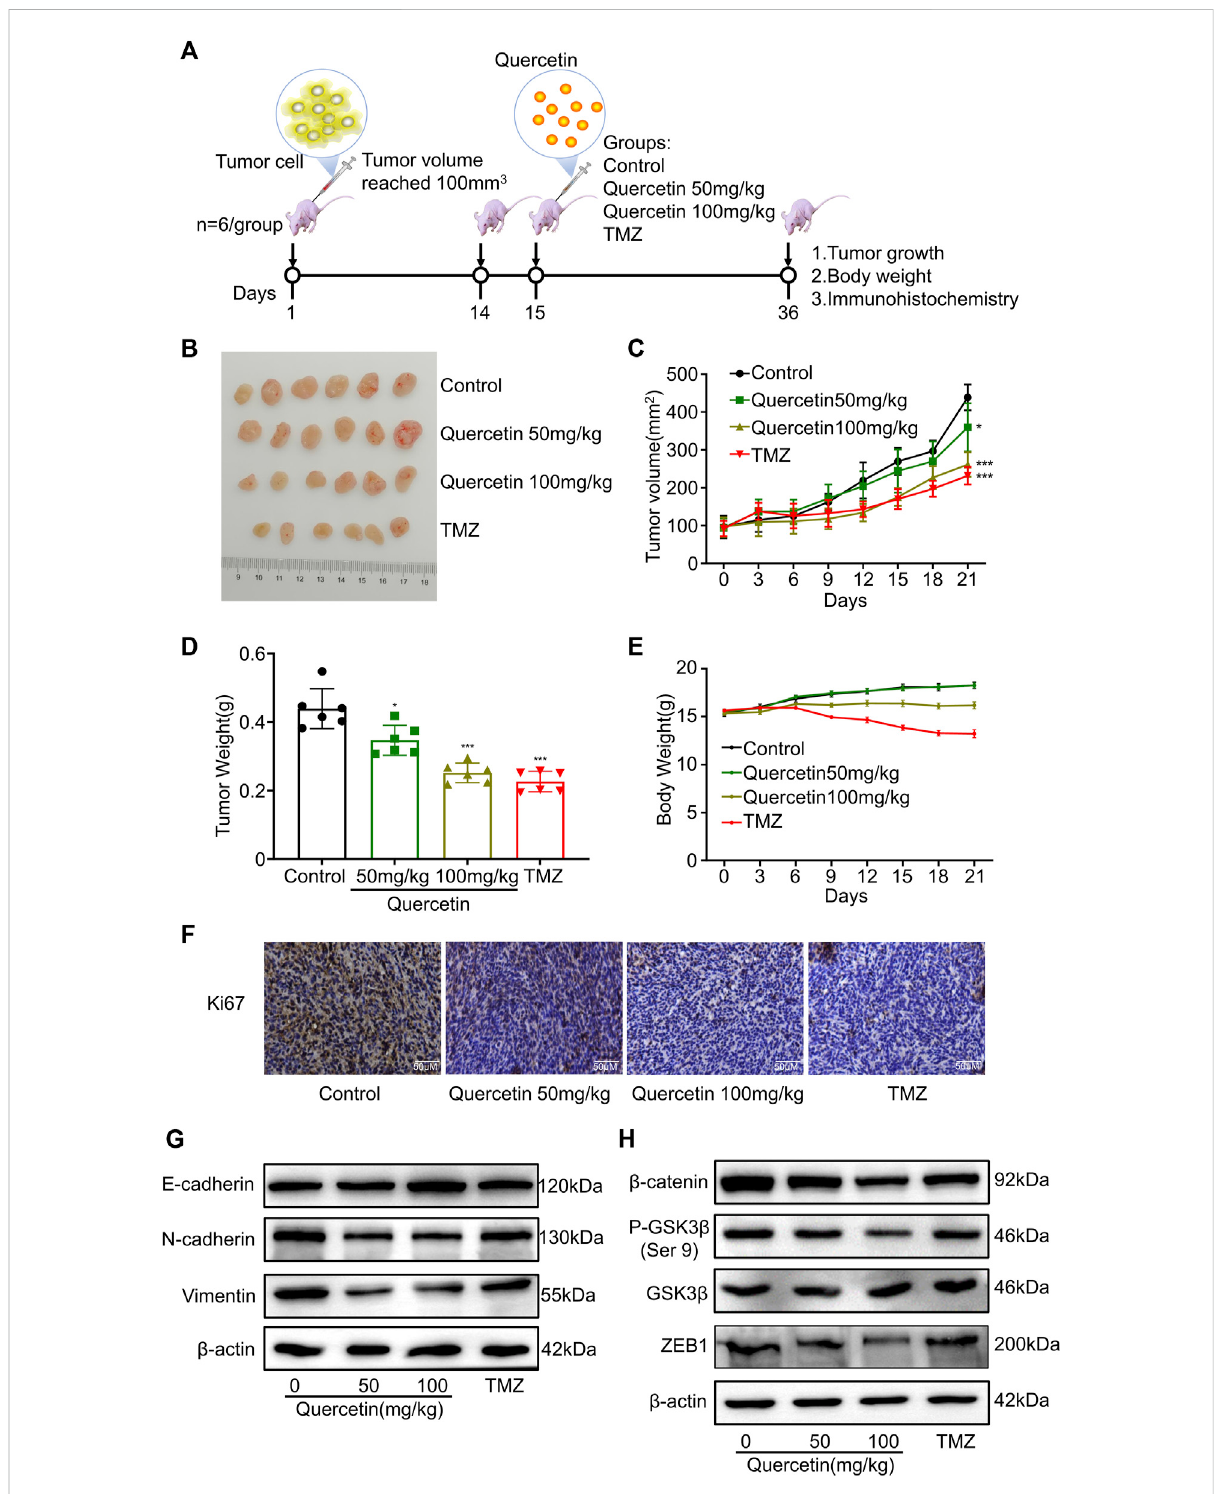
FIGURE 8 Quercetin inhibits EMT-like mesenchymal transition and GBM invasion in vivo. (A) Illustration of in vivo studies of xenograft mouse model. (B) Images of dissected xenografted tumors implanted subcutaneously with U87MG after treatment with quercetin or TMZ for 21 days. n = 6. (C) The volumeoftumorwasmeasured3-dayintervals. n =6. (D) Tumorweightwasmeasuredattheendofthestudy. n =6. (E) Thebodyweightofmicewas monitored every 3 days. n = 6 (F) Ki67 staining was detected by immunohistochemistry in tumor tissues. Scale bar = 50 μ m. (G,H) Western blotting analysis of the expression of EMT markers (E-cadherin, N-cadherin, and vimentin) and the suppression of GSK-3 β / β -catenin/zeb1 in tumor tissues. All data are shown as the mean ± SD. * p ＜ 0.05, ** p ＜ 0.01 or *** p ＜ 0.0 01 vs. control